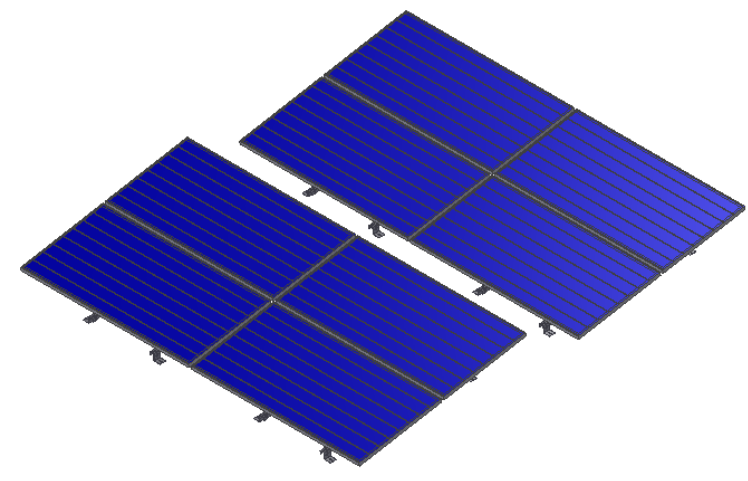
Figure 7. Case II — 3D representation ofTwo-row landscape configuration. Figure 7. Case II—3D representation ofTwo-row landscape configuration.